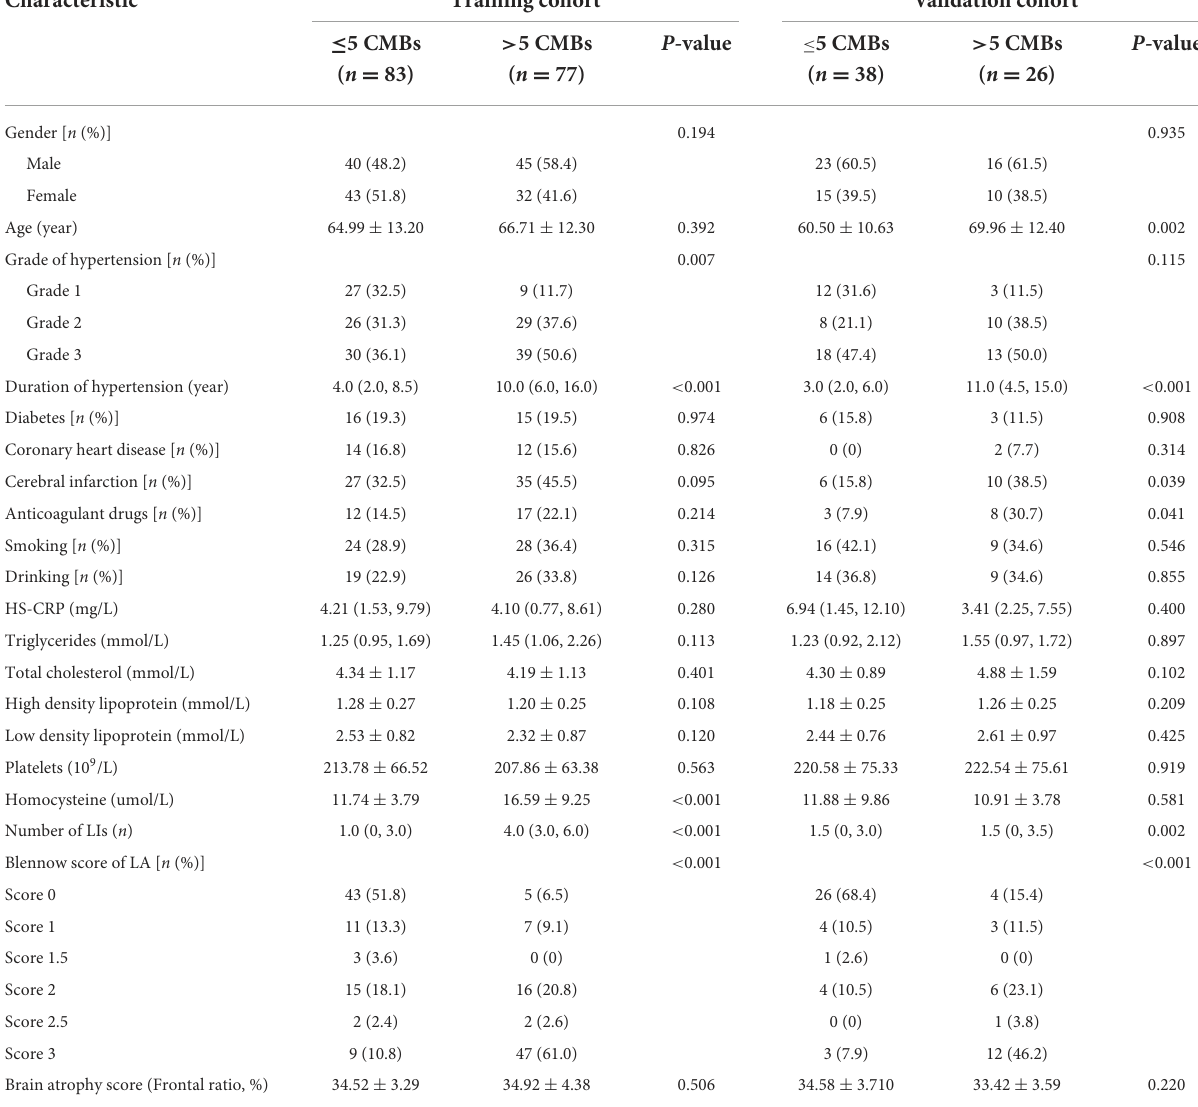
TABLE 1 Comparison characteristics between ≤ 5 cerebral microbleeds (CMBs) and > 5 CMBs group. Characteristic Training cohort Validation